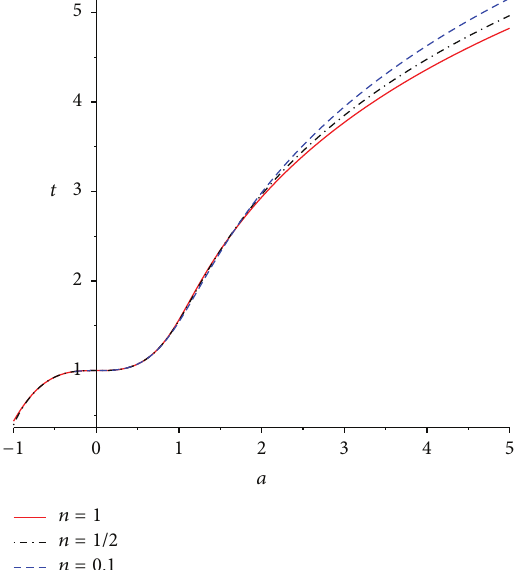
Figure 1: The Figure represents the scale factor 𝑎(𝑡) against 𝑡 for 𝐴 ̸= −1 .